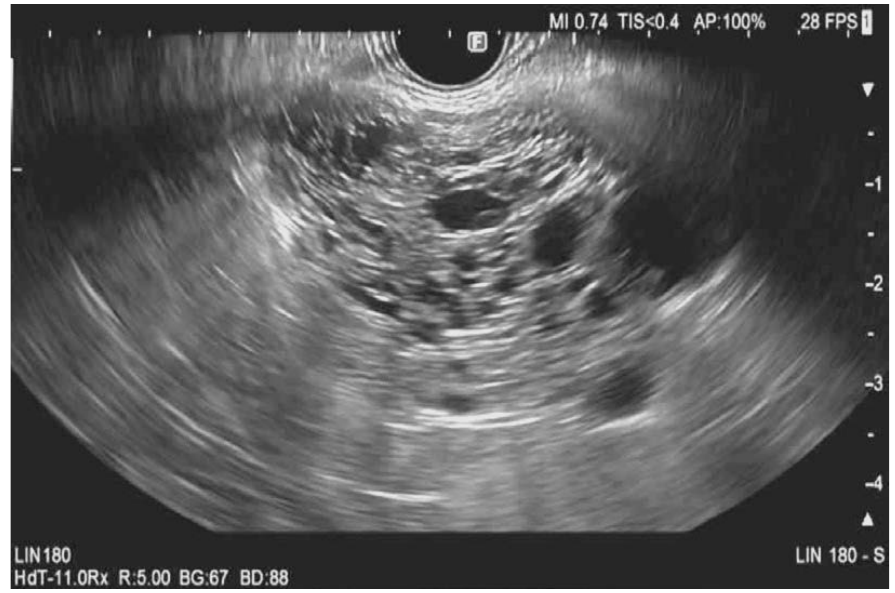
Figure 1. Endoscopic ultrasound morphology of a microcystic serous cystadenoma. This ultrasound image shows a microcystic serous cystadenoma with innumerable small cystic spaces separated by thin septations.